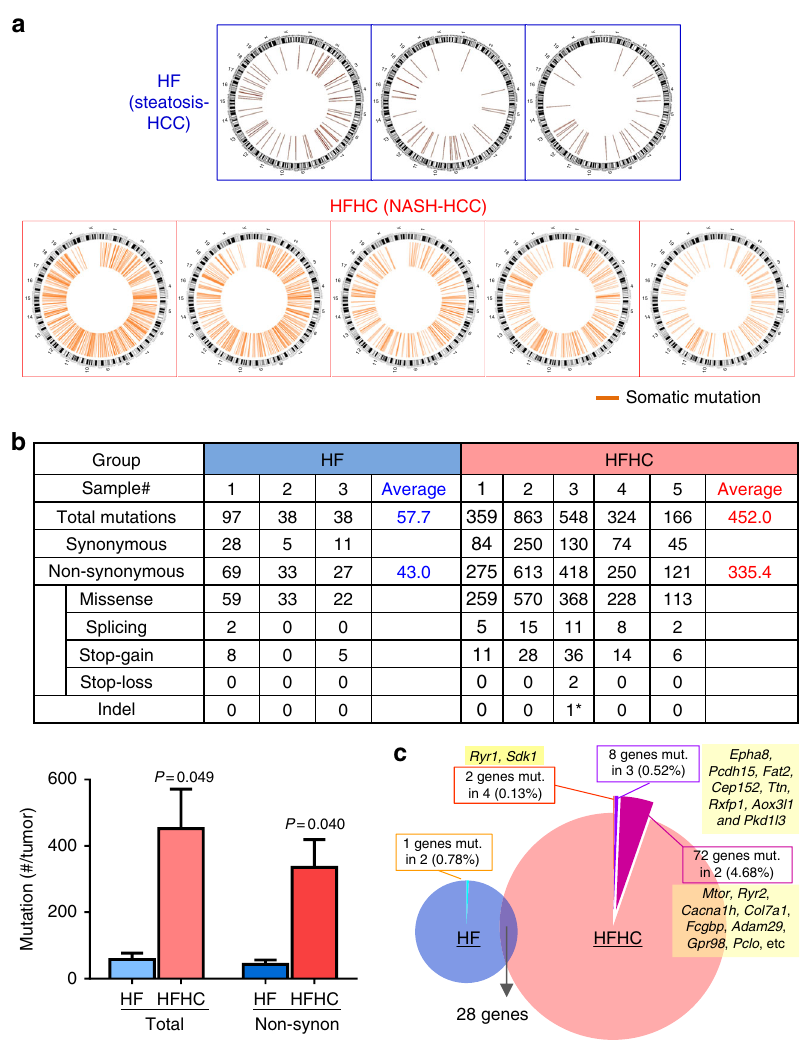
Fig. 5 NASH-HCCs from HFHC-fed mice harbored signi fi cantly more mutations than steatosis-HCCs from HF-fed mice. a Circos indication of somatic mutations identi fi ed by whole-exome-sequencing. b Numbers of somatic mutations in each sample classi fi ed according to mutation types. *only 1 indel